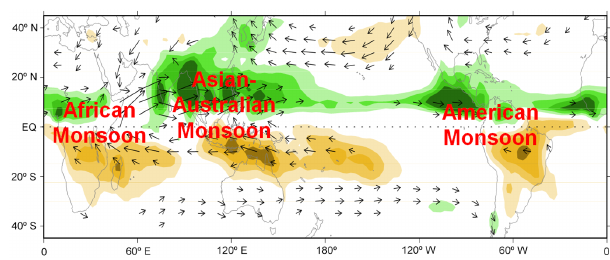
Figure 1. Global monsoon domain and its local components, in- dicating by the differences of 850hPa wind and precipitation between the June–July–August and December–January–February mean, modified from Wang and Ding